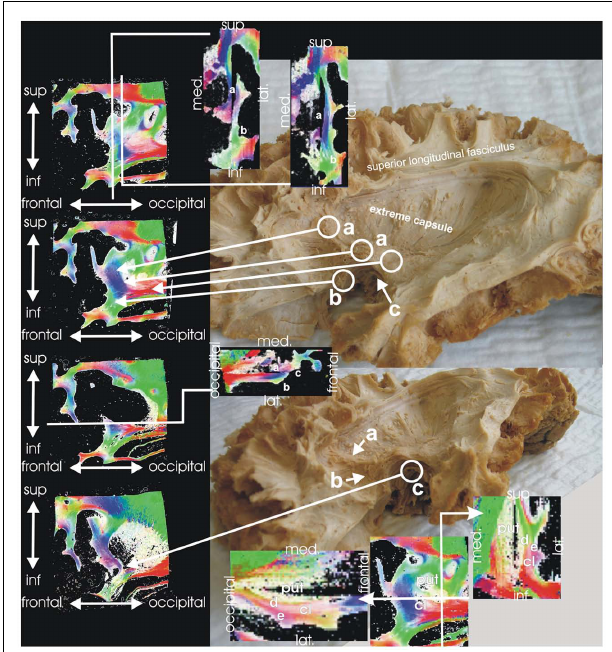
FIGURE 8 | Extreme capsule. Macroscopical fiber dissection and PLI of the white matter in the deep of the limen insulae show comparable results. Different nerve fibers can be distinguished running from the temporal to the frontal lobe: fibers from the extreme capsule to the frontal operculum (a), fibers from the extreme capsule to the orbitofrontal cortex (b), and fibers from the amygdala to the orbitofrontal cortex (c, the uncinate fasciculus).The uncinate fasciculus is localized more deeply than the other two fiber systems and can be clearly distinguished from these.The figures at the bottom show fiber orientation maps through putamen (put) and claustrum (cl), where external (d) and extreme capsule (e) can clearly be distinguished from each